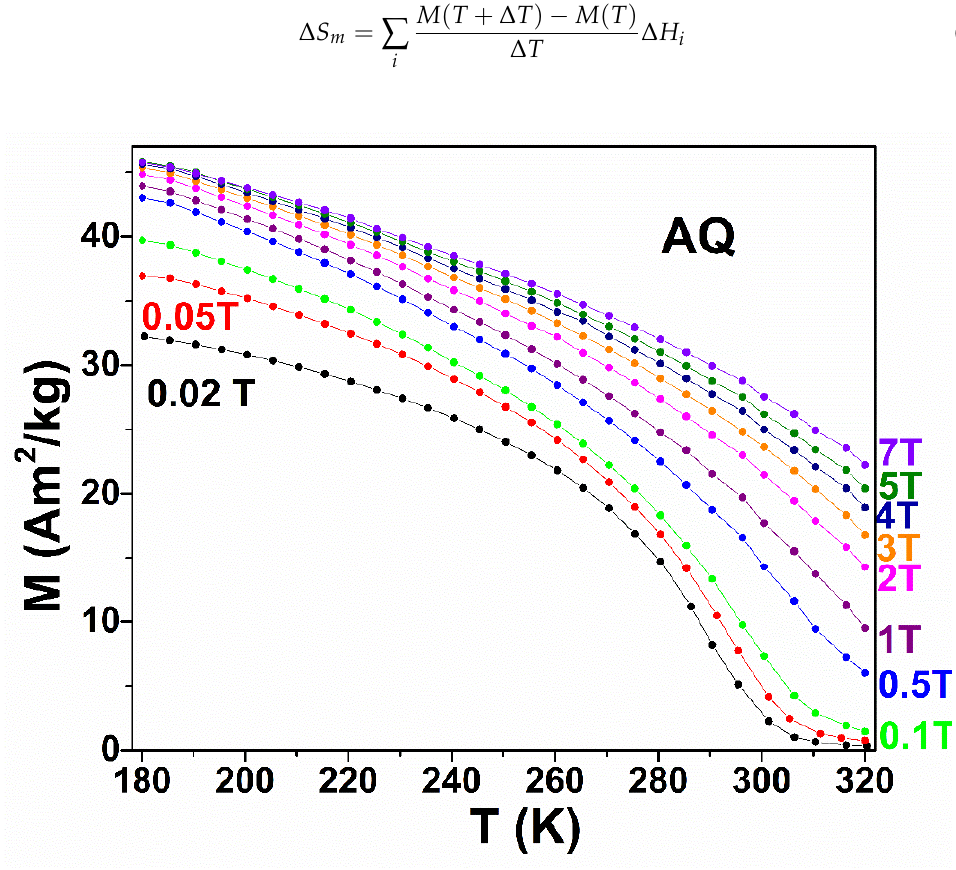
Figure 5. Temperature dependence of magnetization at different applied magnetic fields for AQ ribbon s.